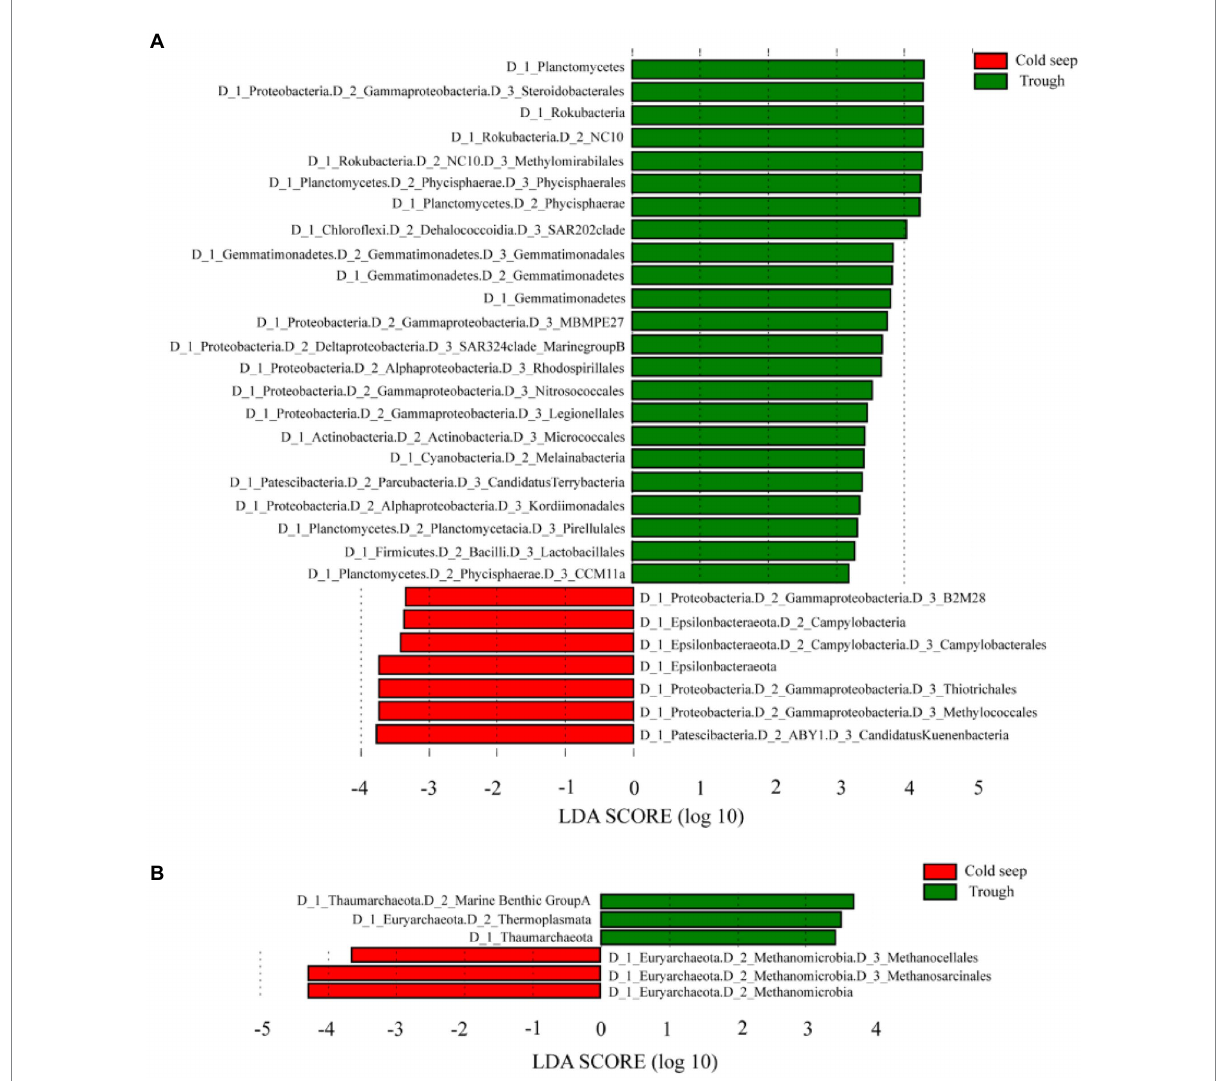
FIGURE 3 LEfSe analysis between the cold seeps and the trough for bacteria (A) and archaea (B) showing the Linear Discriminant Analysis (LDA)